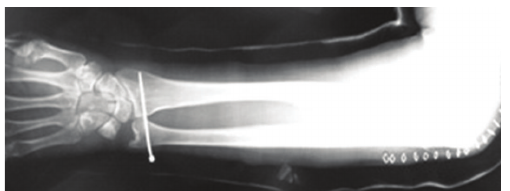
Figure4: Distalradioulnar jointwas manually repositioned. 1.5mm Kirchner wire was passed through the